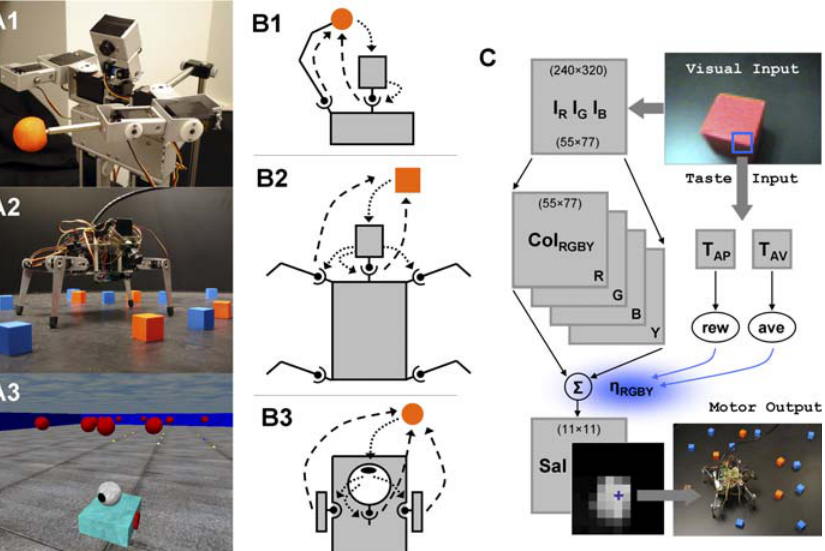
Figure 1. Robots, Sensorimotor Interactions, and Neural Control Architecture